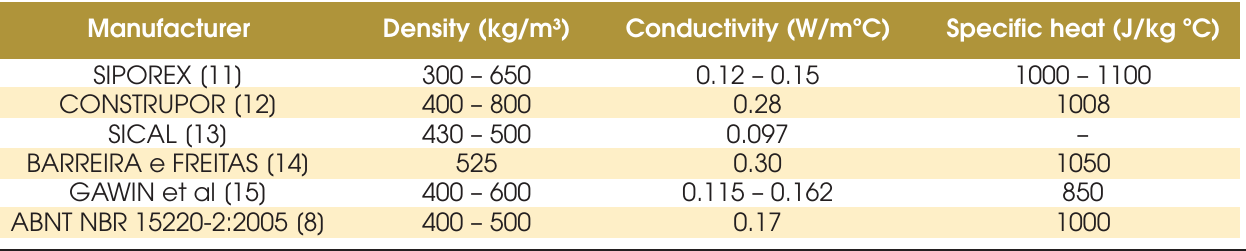
Table 2 – Properties of cellular concrete blocks at room temperature according to manufacturers